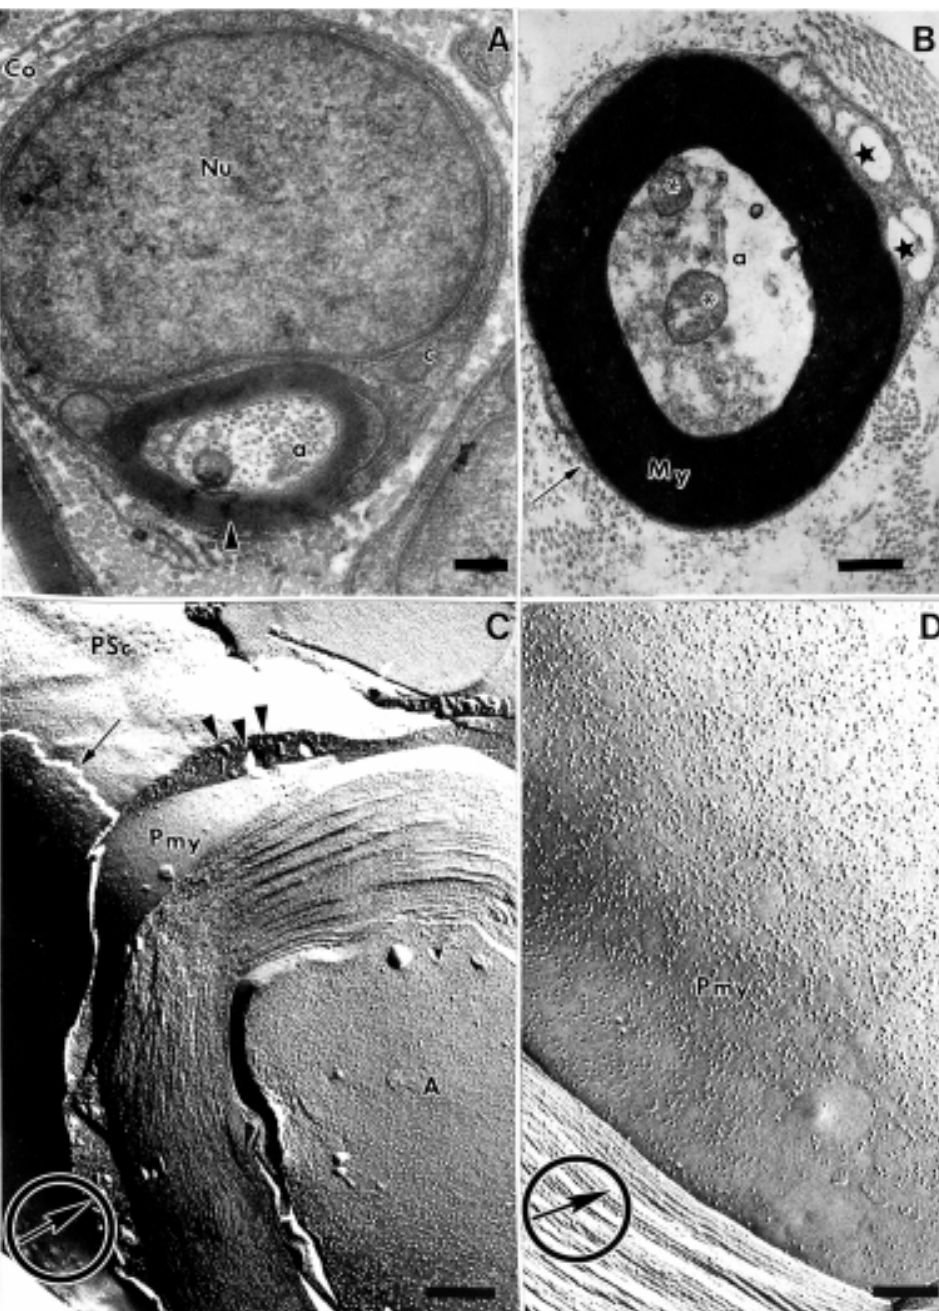
Figure 1 - Transmission electron micrographs of normal and de- generating myelinated nerve fi- bers. A , Normal myelinated nerve fiber showing typical axo- plasm content (a), compact my- elin lamellae (arrowhead), Schwann cell cytoplasm (c), nucleus (Nu) and collagen fibrils (Co). B , Degenerating nerve fi- ber showing an almost com- plete disintegration of axoplasm (a), apparently normal myelin sheath (My) and accumulation of organelles (asterisks). Ob- serve enlarged cisternae of rough endoplasmic reticulum (stars) and the presence of an intact basal lamina (arrow). C , Replica of a myelinated nerve fiber exhibiting the P face of the outer Schwann cell membrane (PSc) and the P face of a myelin lamella (Pmy). The arrow points to mesaxon ridge and arrow- heads to the cytoplasm of Schwann cells. A, Axon. D , Rep- lica of a myelinated nerve fiber showing the P face of a myelin lamella (Pmy) with randomly dis- tributed intramembranous par- ticles. Encircled arrows in the lower left corners of Figure 1C and D indicate the direction of platinum shadowing. Bars: A, D = 0.4 µm; B, C = 0.6